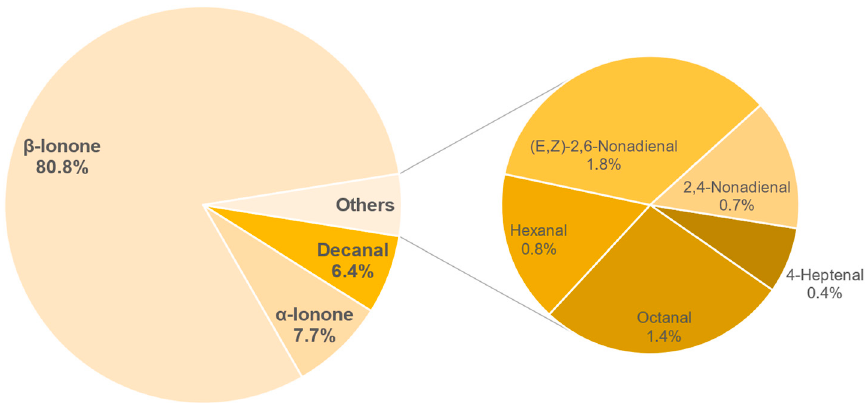
Figure 20. Percentage of OAV of each compound in the total aroma of sample 147.